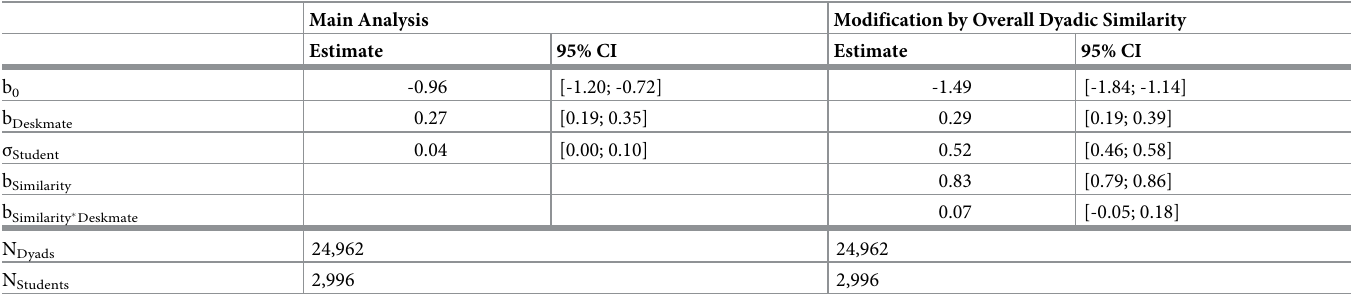
Table 1. Results of Bayesian multi-membership multilevel probit models for the effects of sitting next to each other on reciprocated